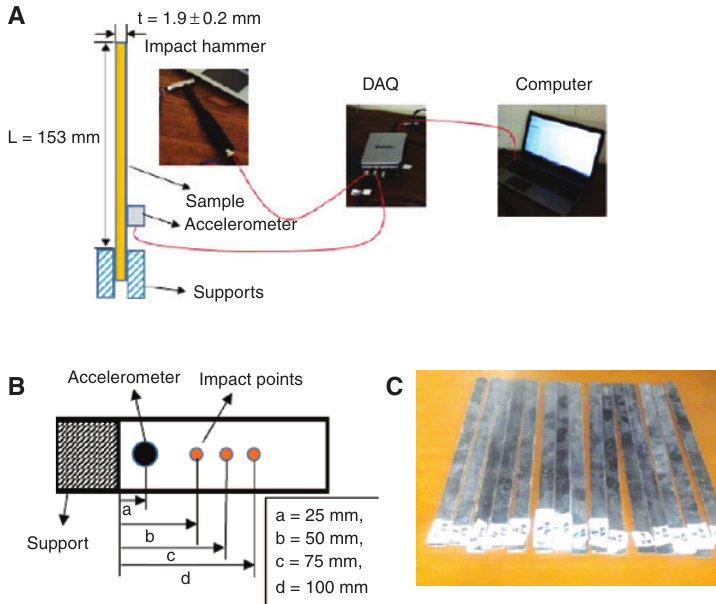
Figure 2: The vibration test mechanism. (A) Set-up for the vibration measurements, (B) the location of acceleration and impact points, (C) the test samples for the vibration